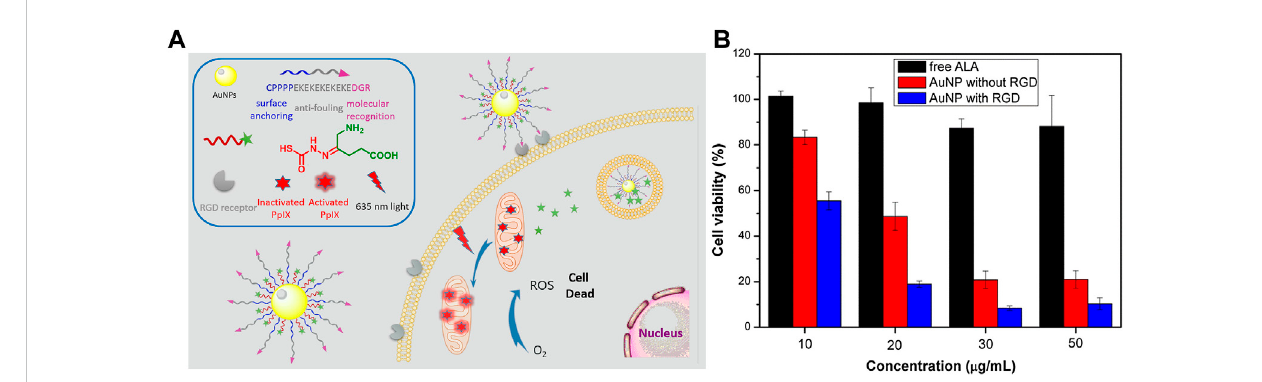
FIGURE 3 Schematic illustration of the preparation of Fe 3 O 4 @ALA-Zn II microsphere and pH-induced release of ALA. Adapted from ref. (Tan et al., 2015). Copyright 2015 WILEY-VCH Verlag GmbH & Co., KGaA, Weinheim.